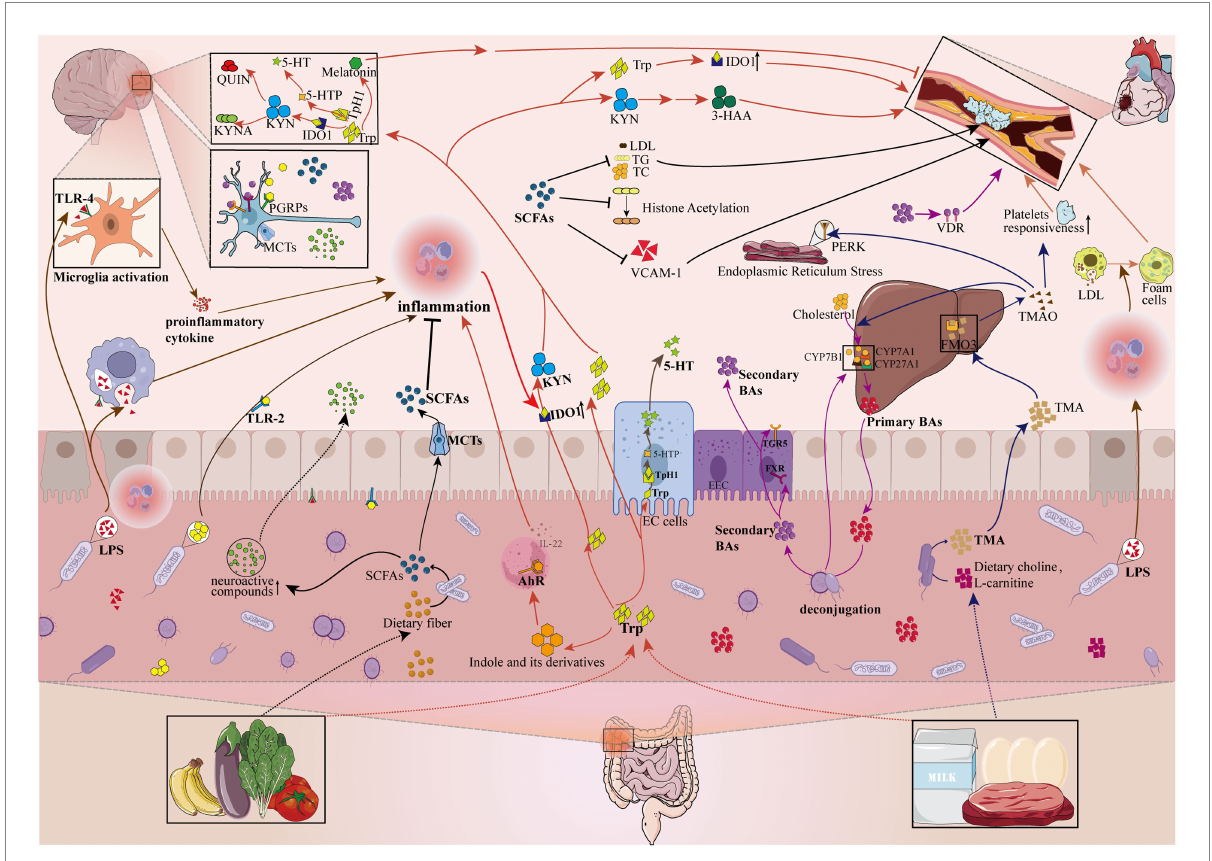
FIGURE 2 Gut microbiome disorders contribute to the pathologic development of depression and atherosclerosis by influencing metabolites. The gut microbiome can affect the pathological development of depression and atherosclerosis by participating in or mediating the production of metabolites (e.g., Pathogen-associated molecular patterns, Bile acids, Tryptophan metabolites, Short-chain fatty acids, Trimethylamine N-oxide). LPS, lipopolysaccharide; PGN, peptidoglycan; TLR-4, Toll-like receptors 4; TLR-2, Toll-like receptors 2; PGRPs, peptidoglycan recognition proteins; SCFAs, short-chain fatty acids; MCTs, monocarboxylic acid transport proteins; LDL, low-density lipoprotein cholesterol; TG, triglyceride; TC, total cholesterol; VCAM-1, vascular cell adhesion molecule-1; Trp, tryptophan; 5-HT, 5-hydroxytryptamine; KYN, kynurenine; AhR, aromatic hydrocarbon receptor; ECs, enterochromaffin cells; IDO1, indoleamine-2,3-dioxygenase 1; Tph1, tryptophan hydroxylase 1; 5-HTP, 5-hydroxytryptophan; KYNA, kynurenic acid; QUIN, quinolinic acid; 3-HAA, 3-hydroxyanthranilic acid; EEC, enteroendocrine cell; FXR, farnesoid X receptor; TGR5, Takeda G protein-coupled receptor 5; CYP7A1, cholesterol 7a-hydroxylase; CYP27A1, sterol-27-hydroxylase; CYP7B1, oxysterol 7 α -hydroxylase; VDR, vitamin D receptor; TMA, trimethylamine; FMO3, flavin-containing monooxygenase isoform 3; TMAO, trimethylamine N-oxide; PERK, RNA-dependent protein kinase (PKR)-like ER